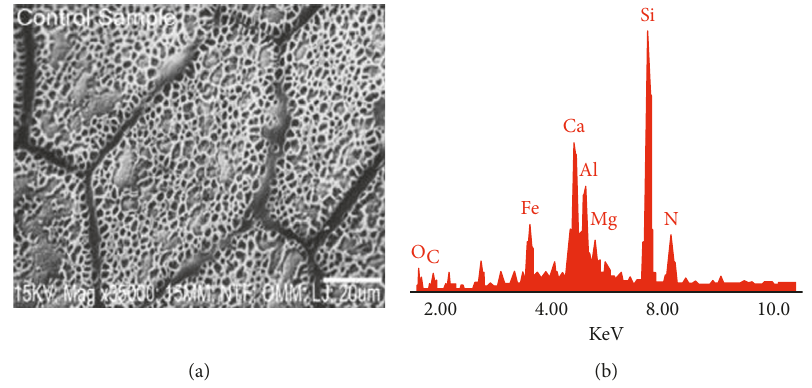
Figure 10: (a) SEM image of AA6061; (b) EDS of AA6061.